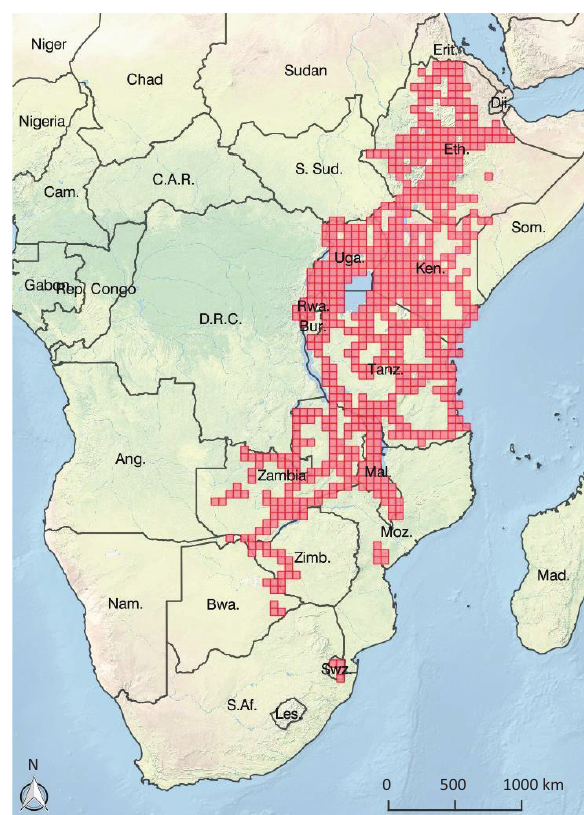
FIGURE 1: Map showing in red (~55 km × 55 km/half degree grid cells) the areas surveyed between 2008 and 2017 for Tithonia species in eastern and southern Africa. Areas surveyed by others in southern Africa are not